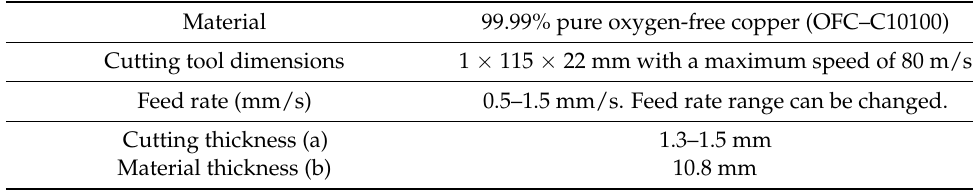
Table 1. Experimental cutting conditions.